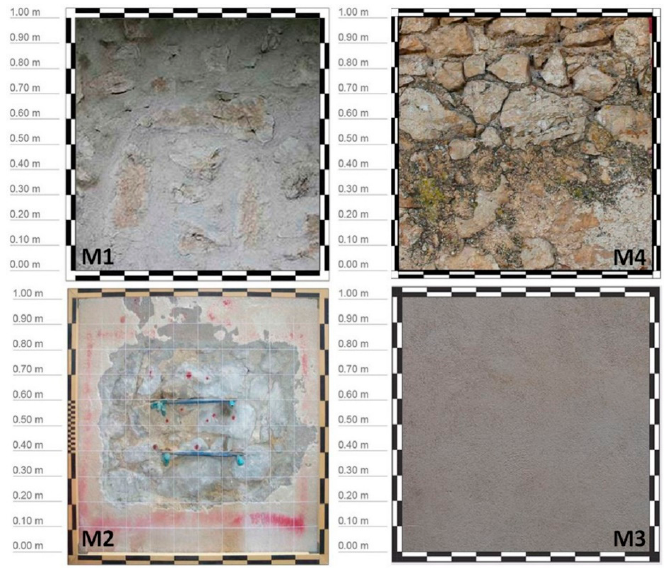
Figure 2. The four most common wall samples.